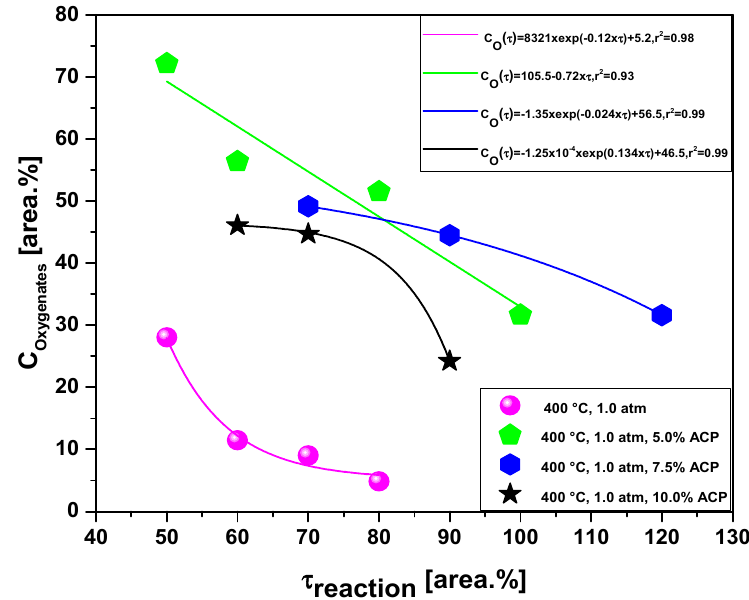
Figure 18. Effect of reaction time on the selectivity of oxygenates by the upgrading of residual fat pyrolysis vapors at 450 ◦ C, 1.0 atmosphere, 0.0%, 5.0%, 7.5%, and 10.0% (wt.) activated carbon pellets impregnated with 10.0 M NaOH, using a catalyst fixed-bed reactor, using a semi-pilot scale two-stage reactor of 2.0 L.